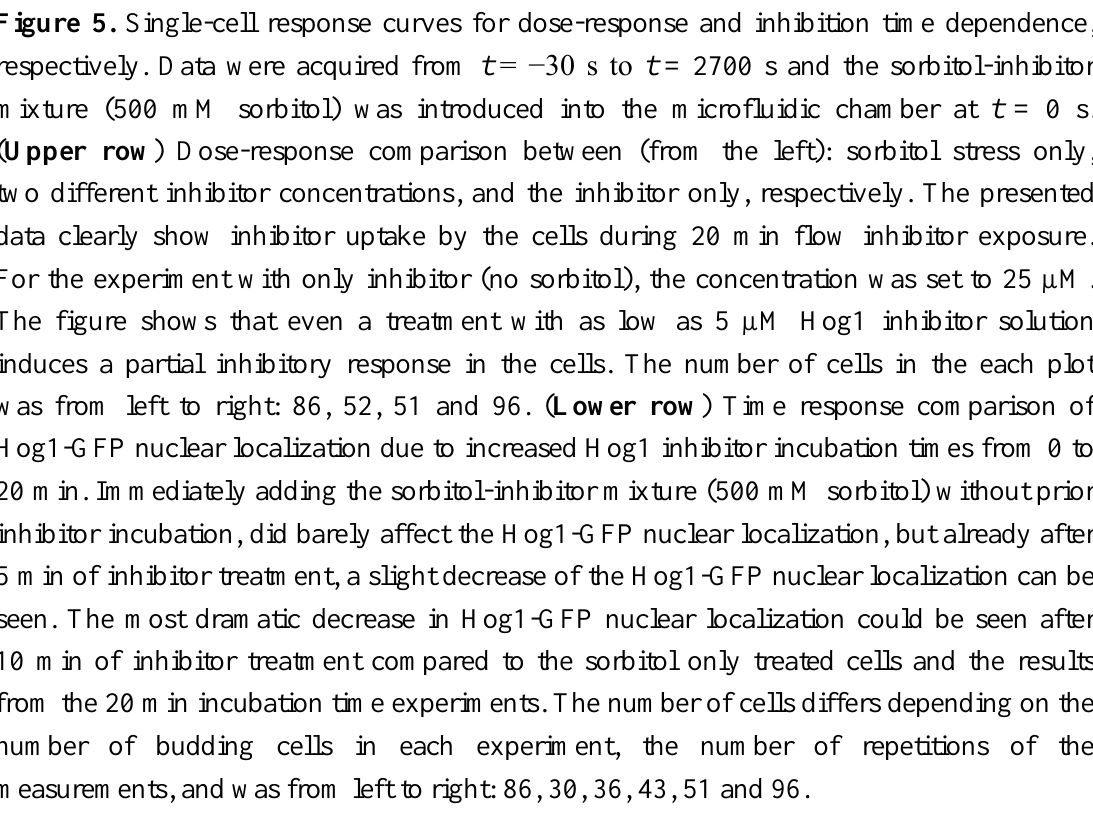
Figure 5. Single-cell response curves for dose-response and inhibition time dependence, respectively. Data were acquired from t = −30 s to t = 2700 s and the sorbitol-inhibitor mixture (500 mM sorbitol) was introduced into the microfluidic chamber at t = 0 s. ( Upper row ) Dose-response comparison between (from the left): sorbitol stress only, two different inhibitor concentrations, and the inhibitor only, respectively. The presented data clearly show inhibitor uptake by the cells during 20 min flow inhibitor